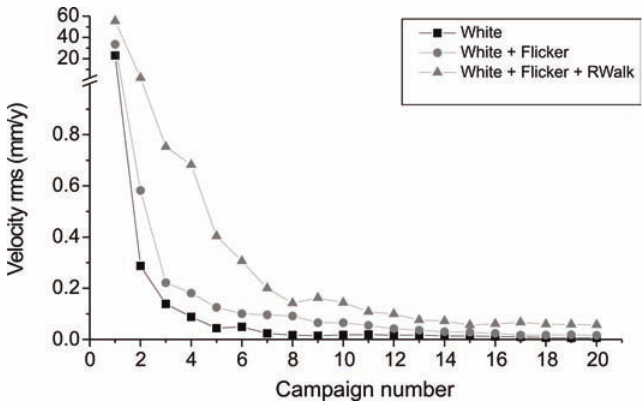
Figure 1. Empirical relationship between the rms of the velocity differences and the campaign numbers using synthetic data from three signals: white noise; white + flicker noise; white + flicker + random-walk